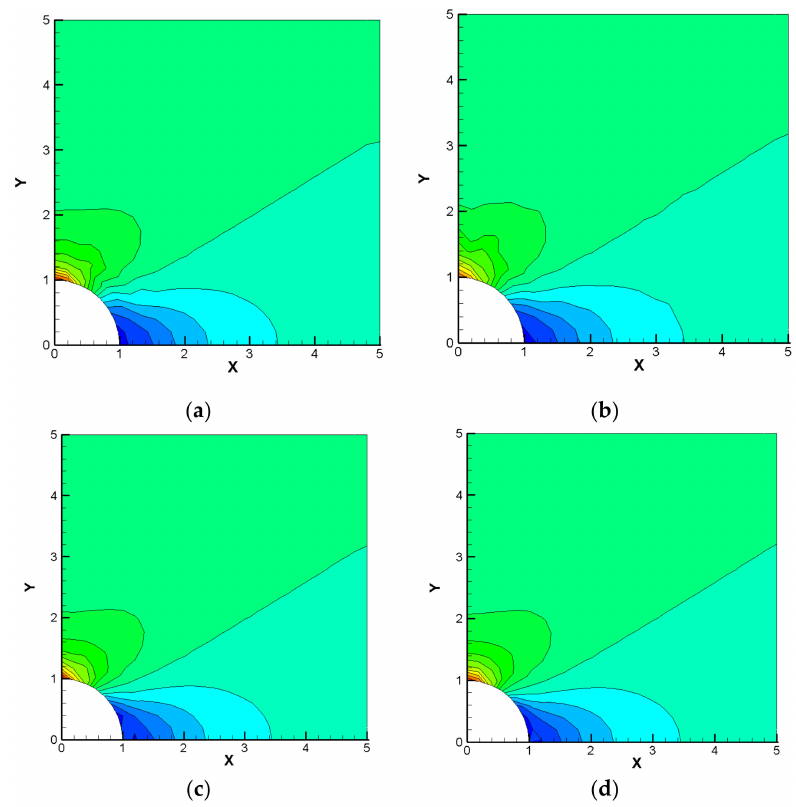
Figure 14. Stress fields in the problem of the plate with a hole obtained by ( a ) FEM; ( b ) RPIM; ( c ) RSUB; ( d ) exact